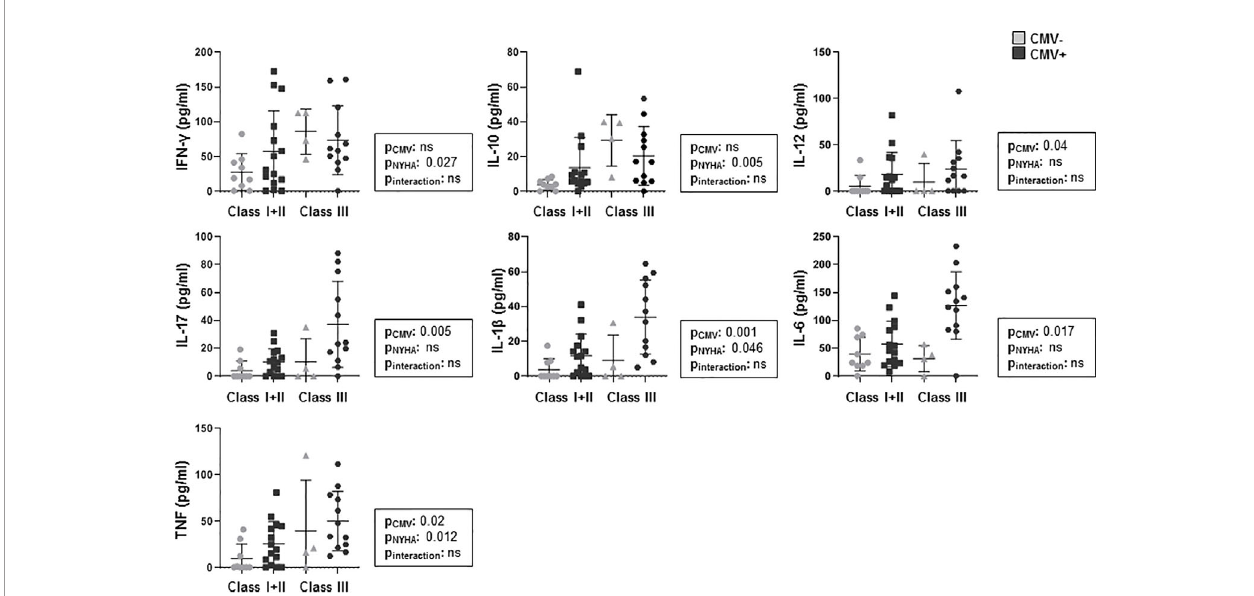
FIGURE 2 | Levels of cytokines analyzed in CHF with respect to the different degrees of HF classi fi ed according NYHA (New York Heart Association) in CMV- and CMV+ patients. Outlier values are represented by circles and extreme values by stars, calculated by adding 1.5 and 3 times the IR to the 75th percentile, respectively. The ANOVA test was used to examine differences between the groups; p-values are depicted in the boxed text; the interaction is between NYHA and CMV serostatus. If signi fi cant interactions were observed, comparisons with a Bonferroni correlated post hoc test were performed and p-values are represented in the